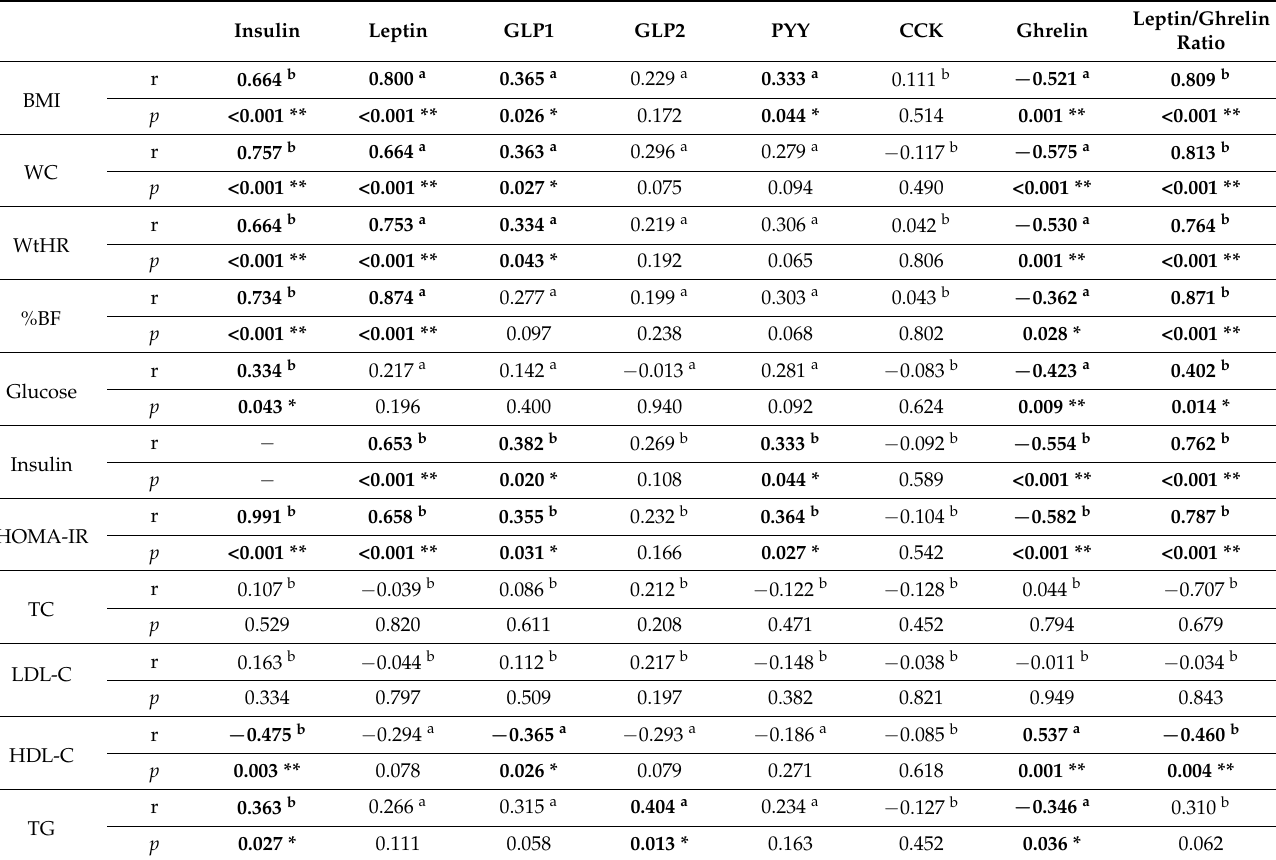
Table 4. Correlations between gut peptides, obesity markers, lipid profile, and glucose homeosta- sis indicators.